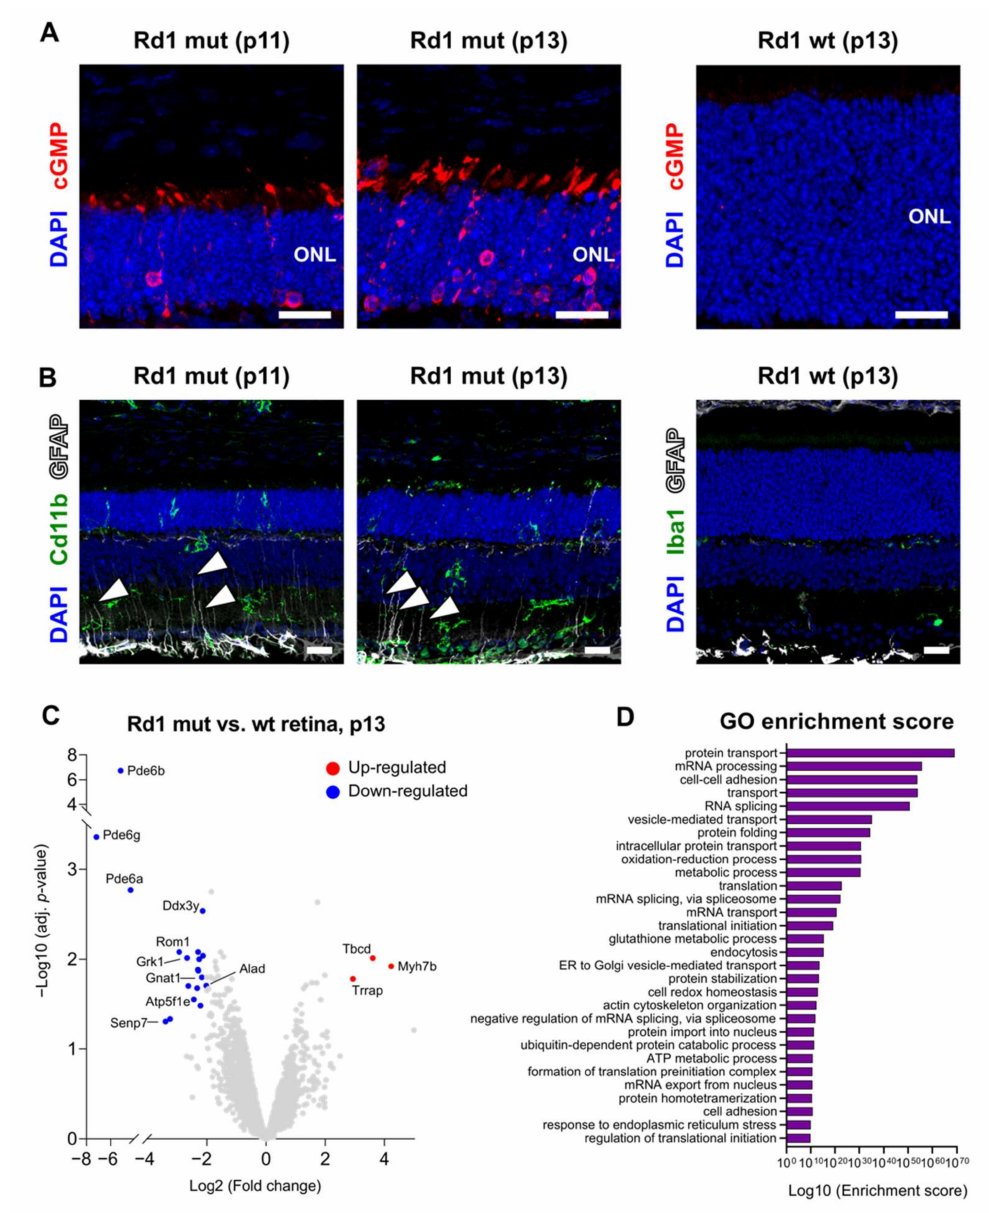
Figure 1. Retinal degeneration in the Rd1 mutant mouse. ( A ) Maximum intensity projection of confocal images showing immunolocalization of cGMP (red) in the outer nuclear layer (ONL) in the Rd1 mutant mouse at p11 and p13 and in the Rd1 wt control at p13. ( B ) Reactivity and distribution of glial cells across different retina layers. Arrowheads indicate the processes of Müller glia cells with a positive GFAP signal. ( C ) Volcano plot of protein expression ratios between Rd1 mutant and Rd1 wt at p13. Dots in blue or red indicate proteins that are significantly down- or up-regulated, respectively. ( D ) Gene Ontology analysis performed on all proteins and showing the 30 terms with the highest enrichment score. Rd1 wt: n = 4; Rd1 mutant: n = 4. Scale bars: 20 µ